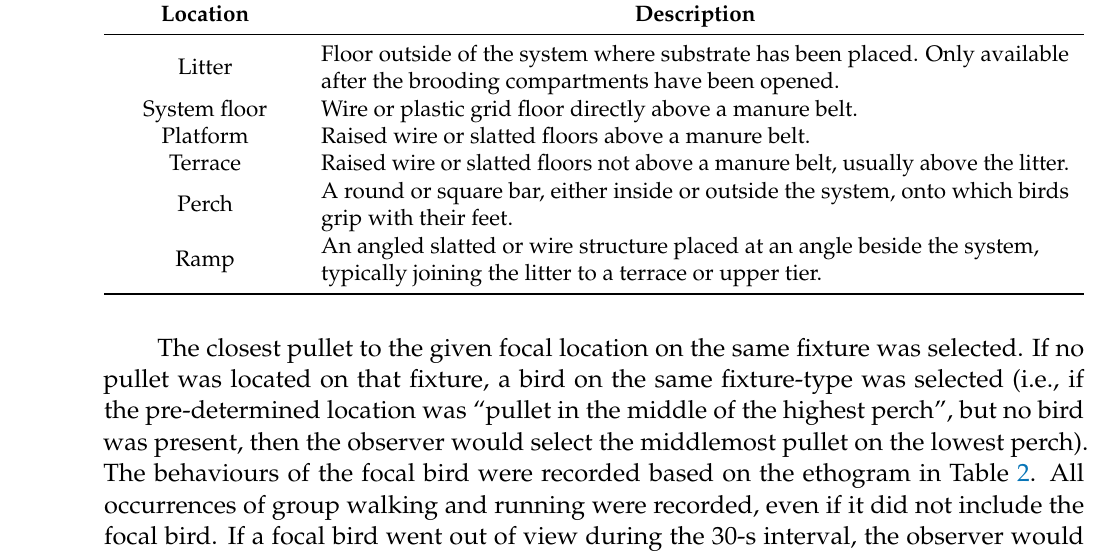
Table 1. Description of different locations available to pullets in the rearing aviaries. Location